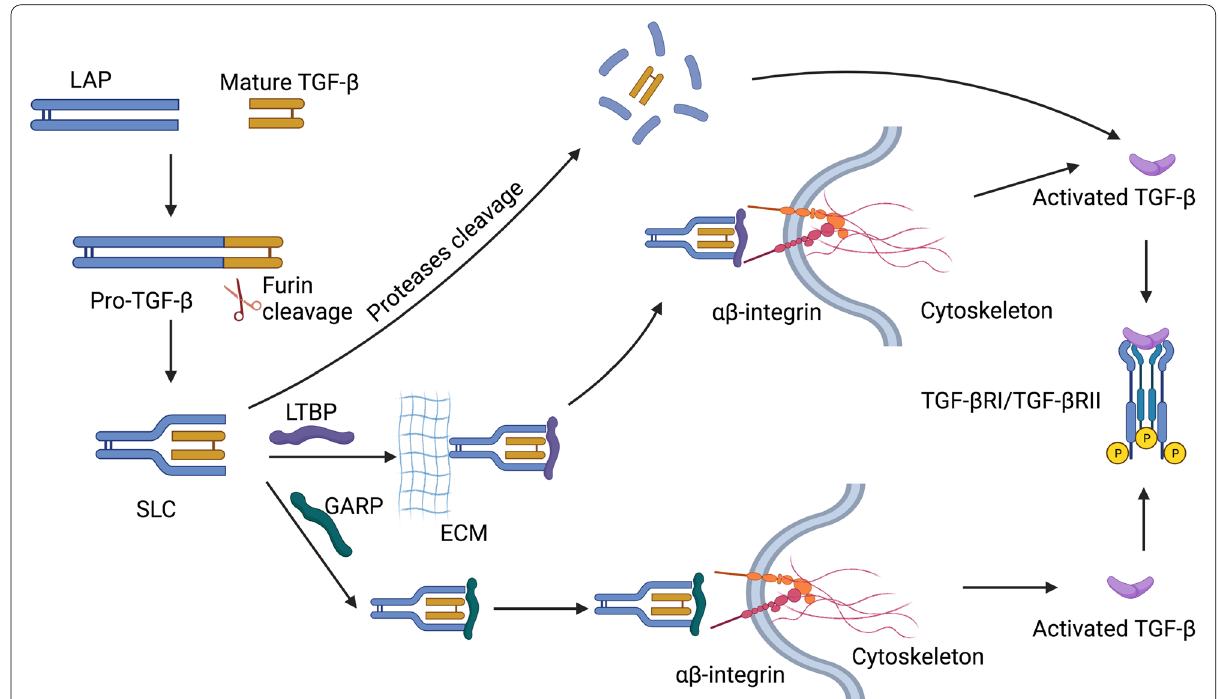
Fig. 1 Schematic diagram and activation of latent TGF-β. The pro-TGF-β precursor consists of an N-terminal peptide with latency-associated peptide (LAP) and a mature C-terminal fragment. The pro-TGF-β precursor is cleaved by the convertase furin, and then the LAP dimer binds to mature TGF-β and forms the small latent complex (SLC). Proteases including plasmin, cathepsin and matrix metalloproteinase 9/14 (MMP9/14)) can cleave LAP and release active TGF-β in the extracellular matrix (ECM). SLC binds to latent TGF-β-binding protein (LTBP) with ECM proteins, including fibronectin and fibrillin, mediating the release of active TGF-β via interaction with αβ-integrin. TGF-β can also be activated through SLC anchoring to glycoprotein A repetition predominant protein